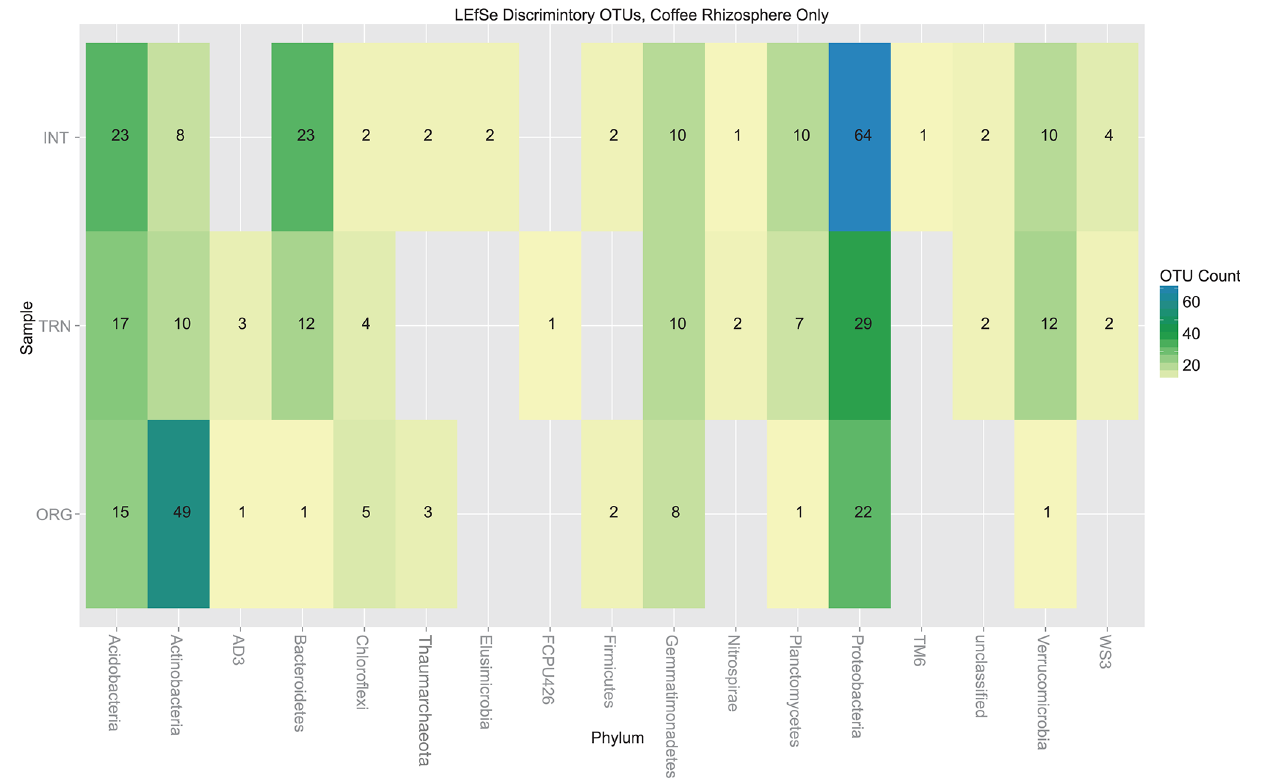
Fig 3. LEfSe discriminatory OTUs among coffee rhizosphere samples. Heatmap of LEfSe results. The number of discriminatory OTUs in each phylum is shown in corresponding box for each of the three sample sites (INT, TRN, and ORG). Statistic calculated in mothur and results plotted in R.